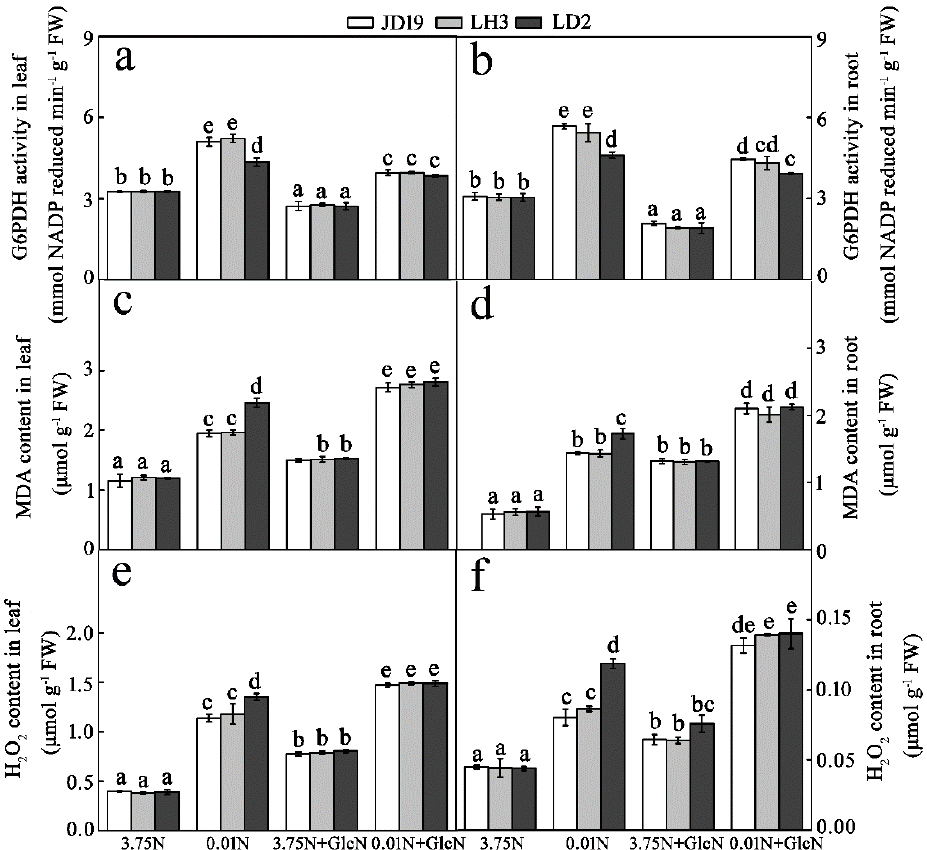
Figure 3. Effects of glucosamine (GlcN, a competitive inhibitor of G6PDH) on G6PDH activity, MDA, and H 2 O 2 content in three soybean cultivars-. ( a ) G6PDH activity, ( c ) MDA content, ( e ) H 2 O 2 content in leaves, ( b ) G6PDH activity, ( d ) MDA content, ( f ) H 2 O 2 content in roots. 10 mM GlcN was added into 1/4 Hoagland medium (pH 6.0) with 3.75 N or 0.01 N for 48 h. Data are means ± SE ( n = 3, p < 0.05). The letters show significant differences under N conditions.